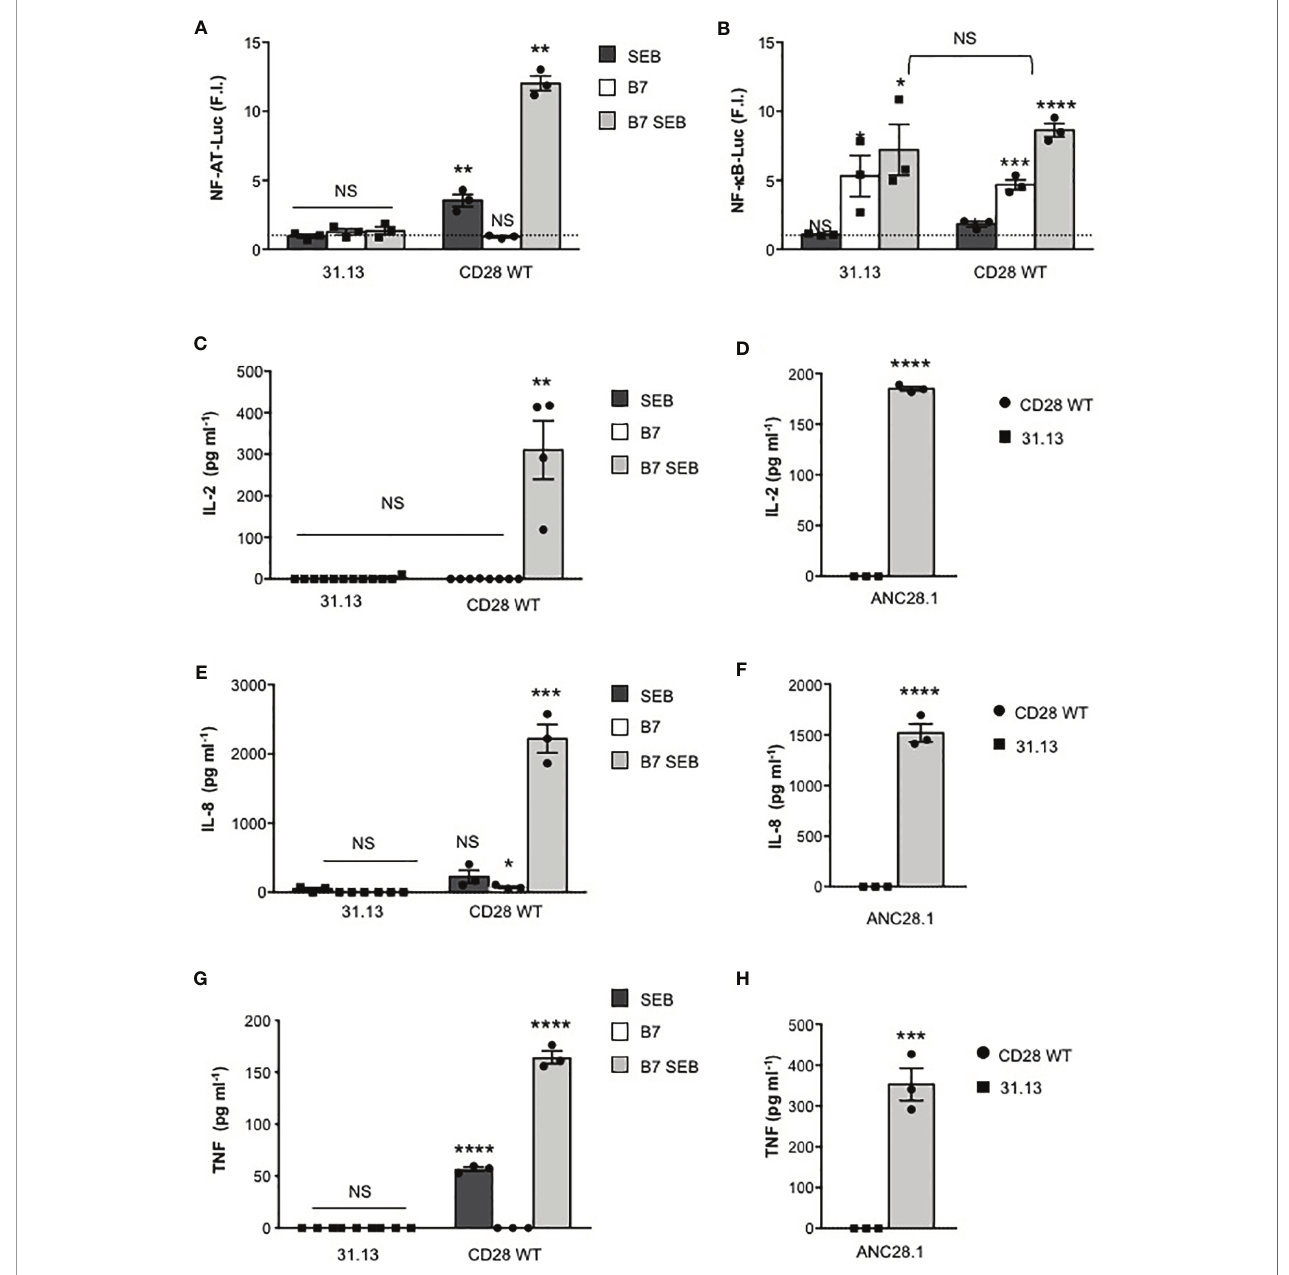
FIGURE 5 | SEB in fl ammatory activity requires TCR signalling. (A, B) TCR-negative 31.13 and CD28WT cells were transfected with GFP together with NF-AT (A) or NF- k B luciferase constructs (B) and then stimulated with 1 m g ml -1 SEB in the presence or absence of Dap3/B7 cells (B7). Data show the mean fold induction (F.I.) ± SEM after normalization to GFP expression of three independent experiments. Statistical signi fi cance was calculated by Student ’ s t test. Mean values: NFAT, 31.31 SEB = 0.9, 31.31 B7 = 1.2, 31.13 B7 SEB = 1.3; CD28WT SEB = 3.5, CD28WT B7 = 0.9, CD28WT B7 SEB = 12; NF- k B, 31.13 SEB = 1, 31.13 B7 = 5.3, 31.13 B7 SEB = 7.2; CD28WT SEB = 1.8, CD28WT B7 = 4.6, CD28WT B7 SEB = 8.6. (C – H) 31.13 and CD28WT cells were unstimulated (Med) or stimulated for 24 hours with SEB in the presence or absence of Dap3/B7 cells (B7) or with 2 µg ml -1 ANC28.1 superagonistic anti-CD28 Abs. The levels of IL-2 (C, D) , IL-8 (E, F) and TNF (G, H) in culture supernatants were measured by ELISA. The result shows the mean ± SEM. Statistical signi fi cance was calculated by Student ’ s t test. Means values: 31.13, IL-2 Med = 0 pg ml -1 , SEB = 0 pg ml -1 , B7 = 0 pg ml -1 , B7 SEB = 2,8 pg ml -1 , ANC28.1 = 0 pg ml -1 ; CD28WT IL-2 Med = 0 pg ml -1 , SEB = 0.4025 pg ml -1 , B7 = 0 pg ml -1 , B7 SEB = 310.2 pg ml -1 , ANC28.1 = 185 pg ml -1 ; 31.31, IL-8 Med = 0 pg ml -1 , SEB = 46 pg ml -1 , B7 = 0 pg ml -1 , B7 SEB = 0 pg ml -1 , ANC28.1 = 0 pg ml -1 ; CD28WT, IL-8 Med = 1.35 pg ml -1 , SEB = 225.9 pg ml -1 , B7 = 73.9 pg ml -1 , B7 SEB = 2221 pg ml -1 , ANC28.1 = 1520 pg ml -1 ; 31.13, TNF Med = 0 pg ml -1 , SEB = 0 pg ml -1 , B7 = 0 pg ml -1 , B7 SEB = 0 pg ml -1 , ANC28.1 = 0 pg ml -1 ; CD28WT, TNF Med = 5.2 pg ml -1 , SEB = 56.7 pg ml -1 , B7 = 0 pg ml -1 , B7 SEB = 164.5 pg ml -1 , ANC28.1 = 353.3 pg ml -1 . (*) p < 0.05, (**) p < 0.01, (***) p < 0.001, (****) p < 0.0001, NS, not signi fi